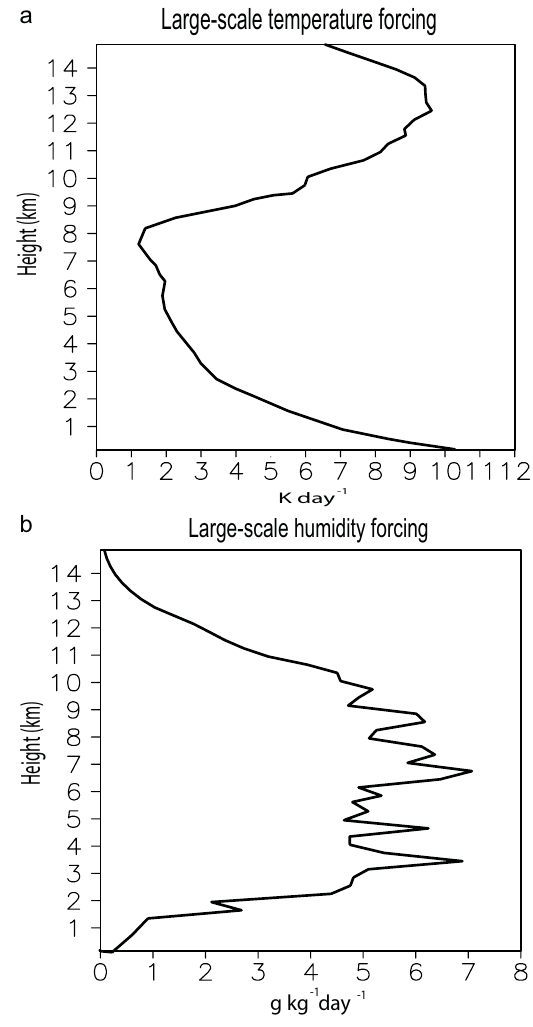
Fig. 2. Vertical distribution of the time- and area-averaged (a) po- tential temperature large-scale forcing and (b) humidity large-scale forcing.